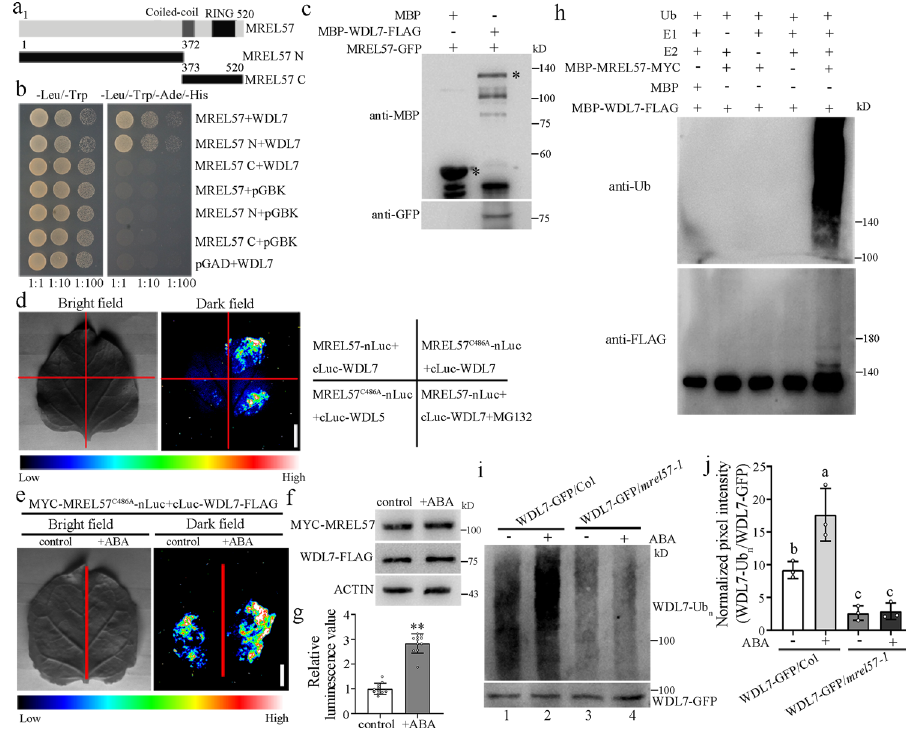
Fig. 5 The E3 ligase MREL57 interacts with and ubiquitinates WDL7. a Schematic representation of MREL57 truncated proteins. b WDL7 interacts with MREL57 and MREL57 N in a yeast two-hybrid assay. c A semi-in vivo pull-down assay showed an interaction between MREL57 and WDL7. MBP-WDL7- FLAG and MBP were marked with asterisks, respectively. The experiment repeated three times with similar results. d Split-luciferase complementation assay to analyze the interaction between MREL57 and WDL7 in N. benthamiana leaves. MG132 at 50 μ M was injected into the leaf tissues 12 h before imaging. The pseudo-color bar shows the range of luminescence. Scale bar = 1 cm. e ABA enhances the interaction between MREL57 and WDL7. MYC - MREL57 C486A -nluc and cluc-WDL7-FLAG were transformed into N. benthamiana leaves. After a 2-day incubation, the leaves were treated with mock buffer or 100 μ M ABA for 2 h. Scale bar = 1 cm. f WDL7 and MREL57 protein levels were detected by western blotting using anti-FLAG and anti-MYC antibodies. Actin was used as a control. g Luminescence values were determined using a spectrophotometer. The experiment was repeated three times. Data represent mean ± standard deviation (SD) values. Two-tailed Student ’ s t test, ** p < 0.01. h MREL57 ubiquitinates WDL7 in vitro. Recombinant proteins were puri fi ed from E. coli and then incubated at 30 °C for 3 h. The ubiquitination of WDL7 was detected with anti-Ub and anti-FLAG antibodies. The experiment repeated three times with similar results. i MREL57 ubiquitinates WDL7 in vivo. WDL7-GFP and WDL7-GFP/ mrel57-1 transgenic seedlings were treated with 0 or 10 μ M of ABA for 1 h in the presence of 50 μ M MG132. Total proteins were extracted and incubated with anti-GFP mAb-magnetic agarose. Anti-Ub was used to detect the polyubiquitination of WDL7. j Quantitative analysis of the signal intensity in i . Data represent the mean ± SD for three independent experiments. Different letters represent signi fi cant differences at p < 0.01 (one-way signi fi cantly lower in mrel57 mutants than in WT (Fig. 6d, e),